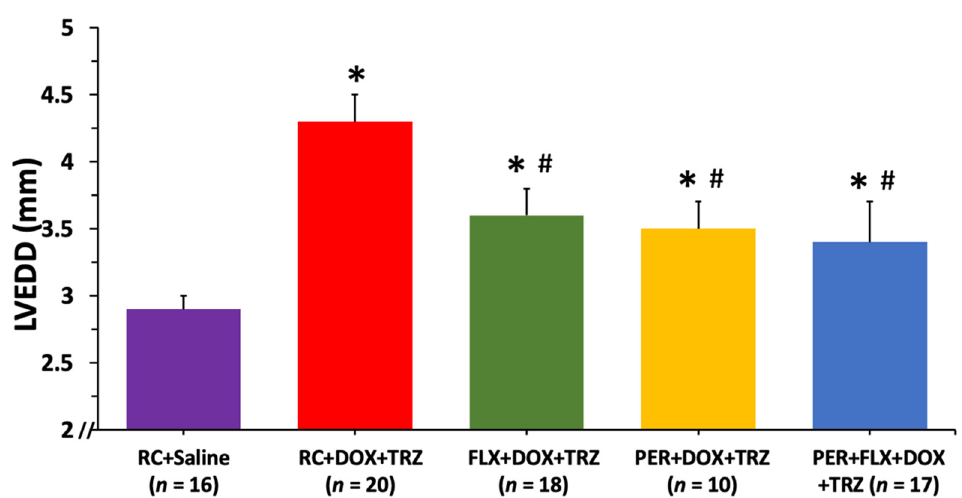
Figure 2. Changes in LVEDD values at week 6 compared to baseline in mice prophylactically ad- ministered FLX, PER, or FLX + PER treated with DOX + TRZ. Female C57Bl/6 mice treated with RC + DOX + TRZ experienced left ventricular cavity dilation as evident by an increase in LVEDD at week 6. Prophylactic treatment with FLX, PER, or FLX + PER significantly attenuated LV cavity dilation associated with DOX + TRZ administration. Data are expressed as mean ± SD. * p < 0.05 RC + DOX + TRZ vs. RC + saline. * # p < 0.05 FLX + DOX + TRZ or PER + DOX + TRZ or PER + FLX + DOX + TRZ vs. RC + DOX + TRZ and RC + saline. DOX, doxorubicin; FLX, flaxseed; LV, left ventricle; LVEDD, left ventricular end diastolic diameter; PER, perindopril; RC, regular chow; SD, standard deviation; TRZ, trastuzumab.